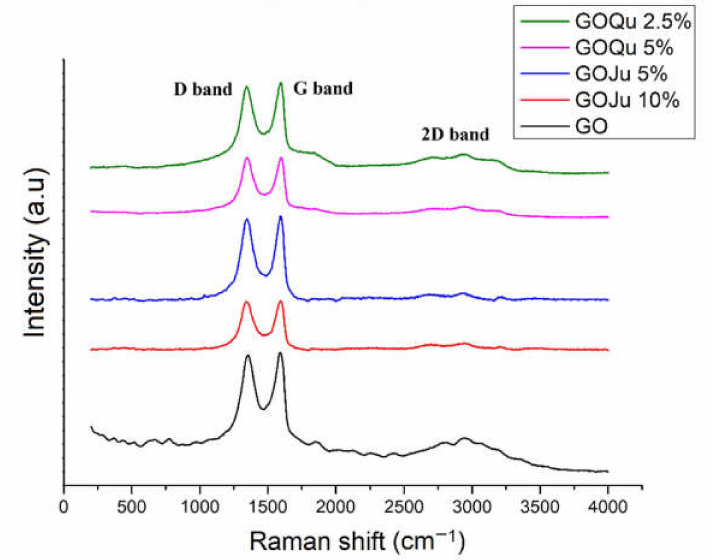
Figure 4. Raman spectra of GOQu 5% ( w / v ), GOQu 2.5% ( w / v ), GOJu 10% ( w / v ), GOJu 5% ( w / v ), and GO